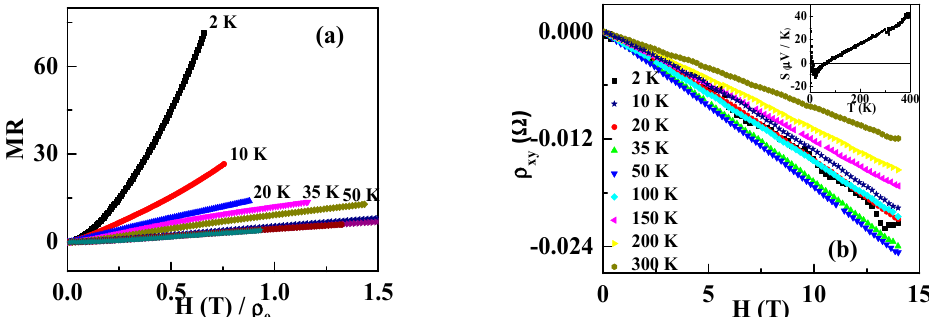
Figure 4. ( a ) The analysis of MR based on the Kohler’s rule; ( b ) the Hall resistivity at different temperatures, and the inset is the variation of the Seebeck coefficient S with temperature.